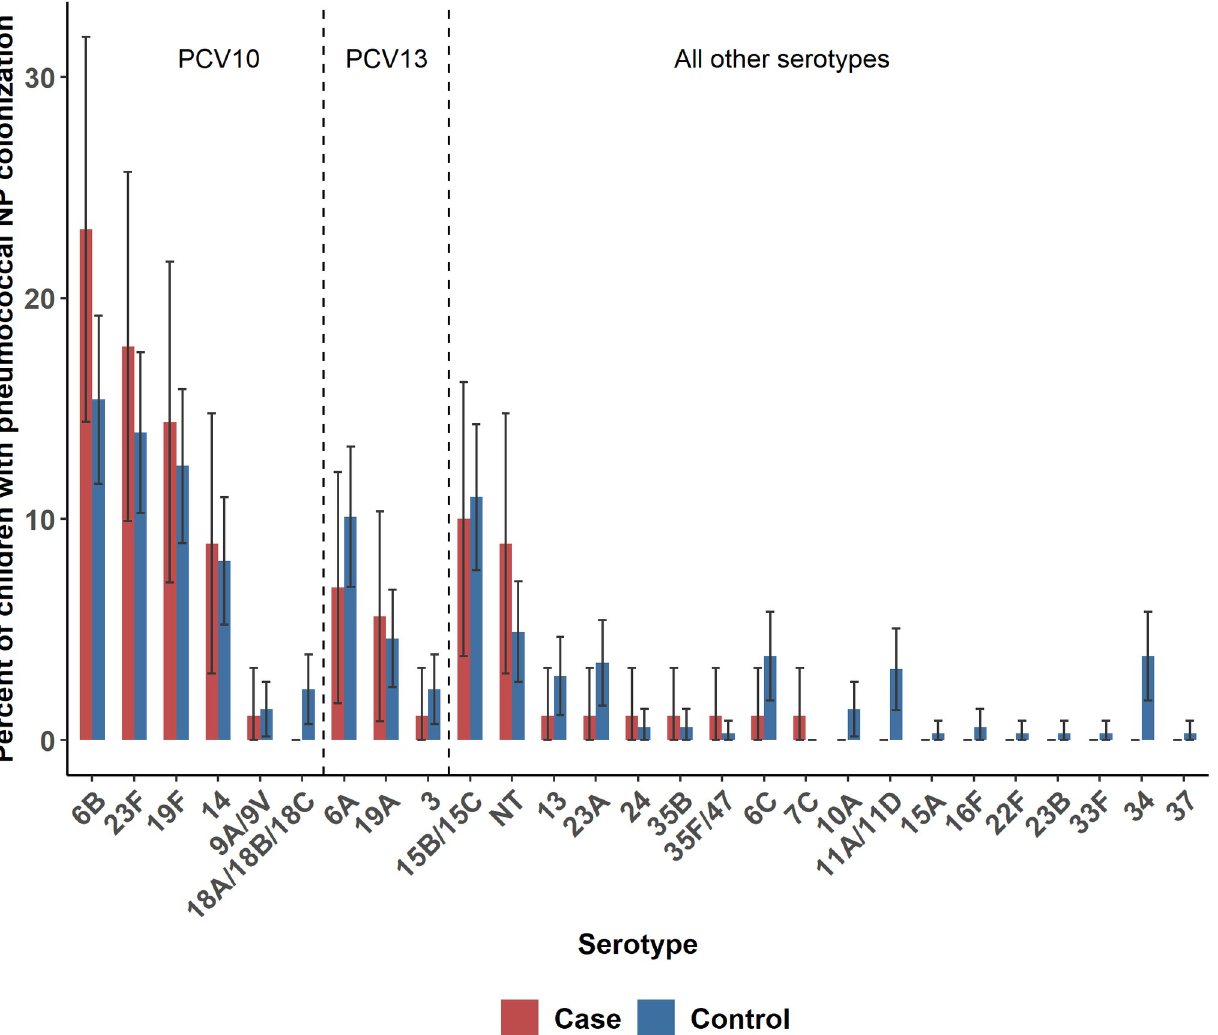
Fig 1. Pneumococcal colonization serotype distribution among pneumonia cases and community controls in rural Thailand. Bars represent the percent of cases or controls with the serotyped detected, restricted to children with NP culture serotyping data. Error bars are 95% Wald confidence intervals. PCV-10 serotypes: 1, 4, 5, 6B, 7F, 9V, 14, 18C, 19F, and 23F; PCV-13 serotypes: PCV-10 serotypes plus serotypes 3, 6A, and 19A. NT, non-